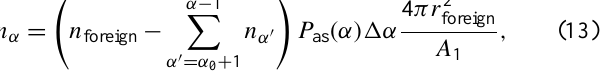
Fig. 3. The number density of foreign nuclei as a function of the contact angle of the best active site on the particle’s